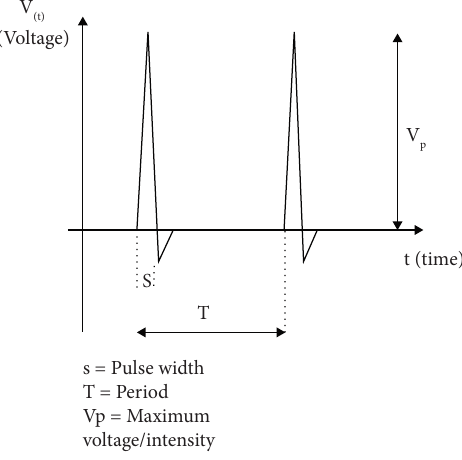
Figure 1: Spike pulse of the electro-stimulator.